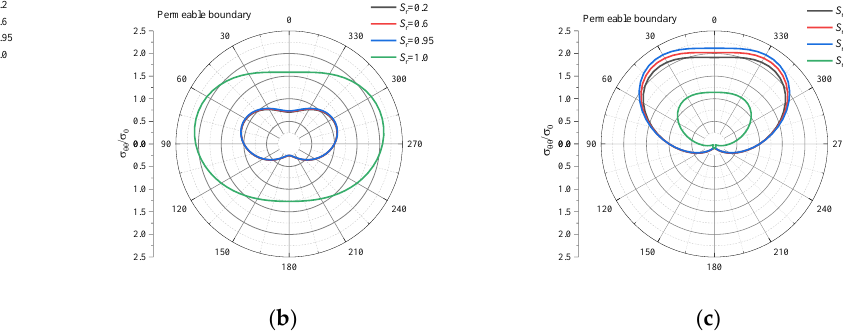
Figure 3. Effects of saturation on distributions of σ S / σ 0 around the surface of the cavity for P 1 wave incidence with the second set of parameters in Table 1 with υ = 0.3 s for a permeable boundary. ( a ) k 0 a = 0.5. ( b ) k 0 a = 1.0. ( c ) k 0 a = 3.0. By comparing the permeable and impermeable boundary conditions, the dynamic stress concentration factor of an impermeable cavity is slightly larger than that of a perme- able cavity for S r = 1.0. For S r < 1.0, there are no obvious differences between the dynamic stress concentration factors of the permeable and impermeable cavities. (2) The influence of Poisson’s ratio on the dynamic responses of the cavity Taking the second set of parameters in Table 1 with S r = 0.6, Figure 4 gives the distri- butions of σ S / σ 0 around the cavity surface for P 1 wave incidence for different Poisson’s ratios of υ = 0.1, 0.2, and 0.3 with k 0 a = 0.5, 1.0, and 2.0 under impermeable conditions, respectively. As can be seen from the figure, with the increase in Poisson’s ratio, the stress increases gradually under different frequencies, and the angle at which the maximum value occurs gradually approaches the direction of the incident wave direction. For example, when k 0 a = 2.0, the maximum values for υ = 0.1 occur at θ = 50 ◦ and 310 ◦ , whereas for υ = 0.2, at θ = 40 ◦ and 320 ◦ , and for υ = 0.3, at θ = 20 ◦ and 340 ◦ . For all Poisson’s ratios, the minimum values appear at θ = 180 ◦ . Moreover, with the increase in the incident frequency, the angle between the maximum value direction and the incident wave direction ( θ = 0 ◦ ) decreases at the same Poisson’s ratio. For υ = 0.3, the maximum values appear at θ = 70 ◦ and 290 ◦ when k 0 a = 0.5, at θ = 40 ◦ and 320 ◦ when k 0 a = 1.0, and at θ = 20 ◦ and 340 ◦ when k 0 a =